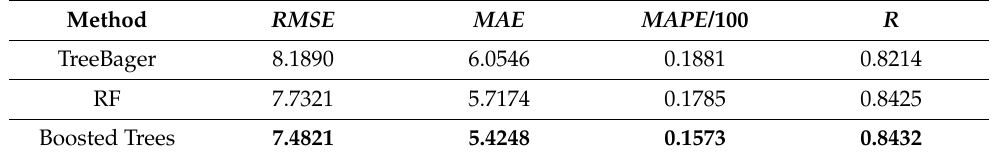
Figure 15. Dependence of MSE values on learning rate and number of base models in Boosted Trees method. Table 5. Comparative analysis of results in Bagging, RF and Boosted Trees